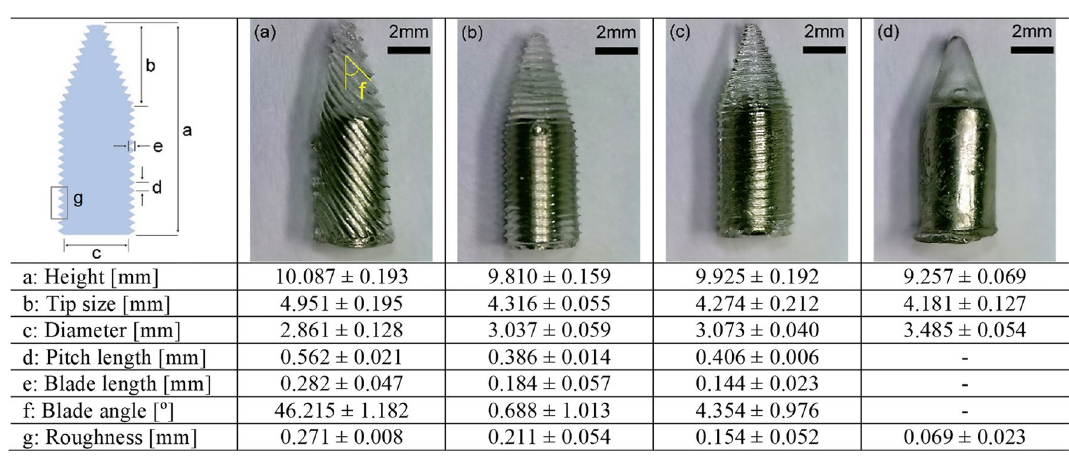
Figure 5. Optical image of fabricated MDDs with ( a ) 45°-tilted blades, ( b ) 0° blades, ( c ) helical blades, and ( d ) no blades (i.e., plain type) and geometrical dimensions of each